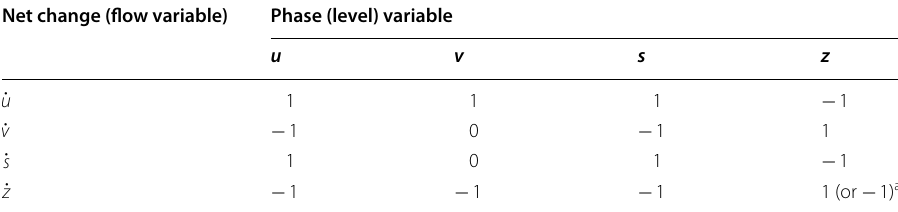
a The first AHB with b critical = 40 implies 1, − 1 is for the second AHB with b critical = 1.39